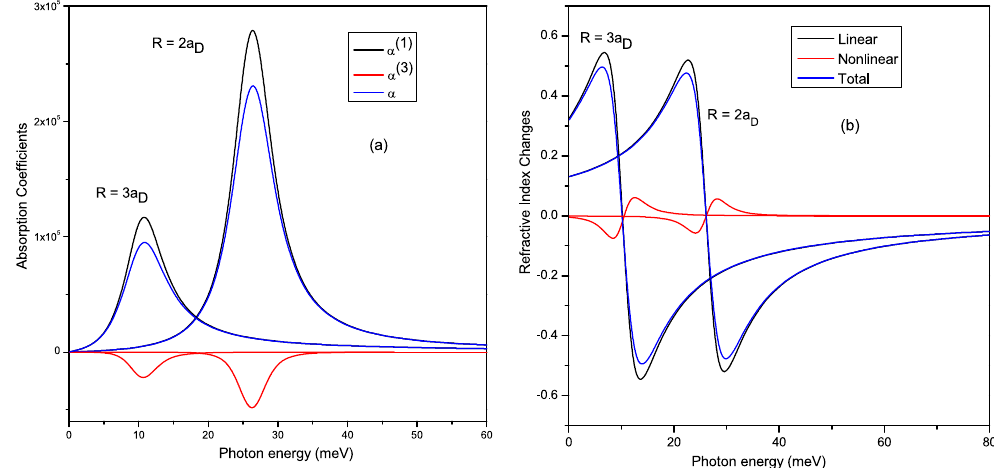
Figure 2. The absorption coefficients ( a ) and the refractive index changes ( b ) as function of incident photon energy ¯ h ω for R = 2 and 3 a D